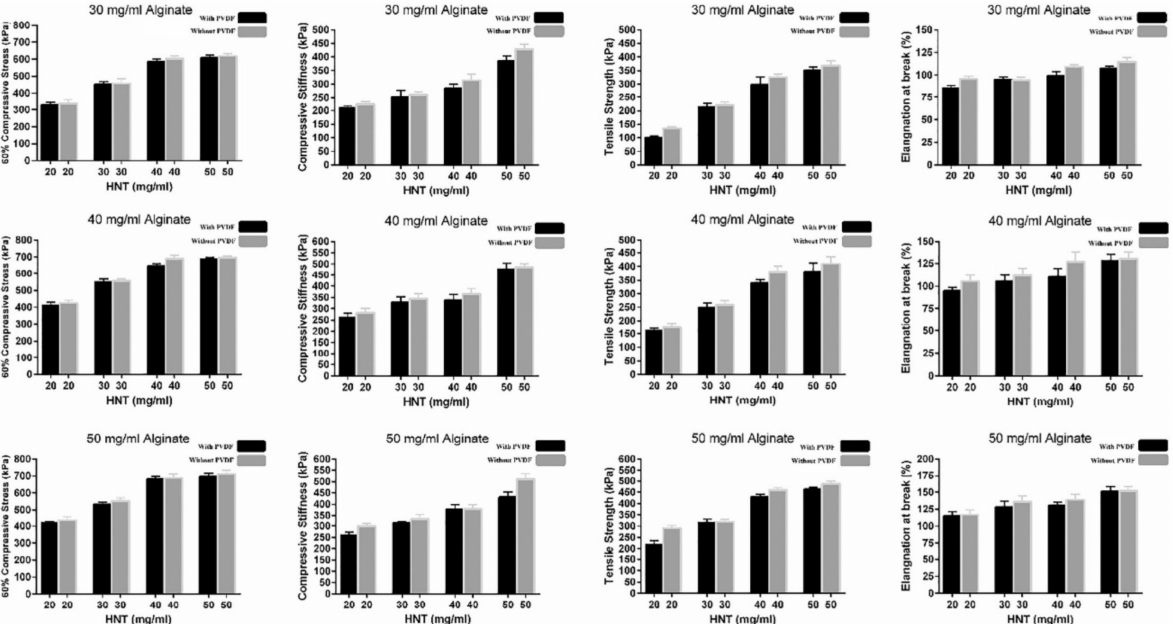
Figure 24. Compressive modulus, compressive stiffness, tensile strength and elongation at break of biomaterials combined with different concentrations of HNTs. Reproduced with permission from [91], Elsevier,